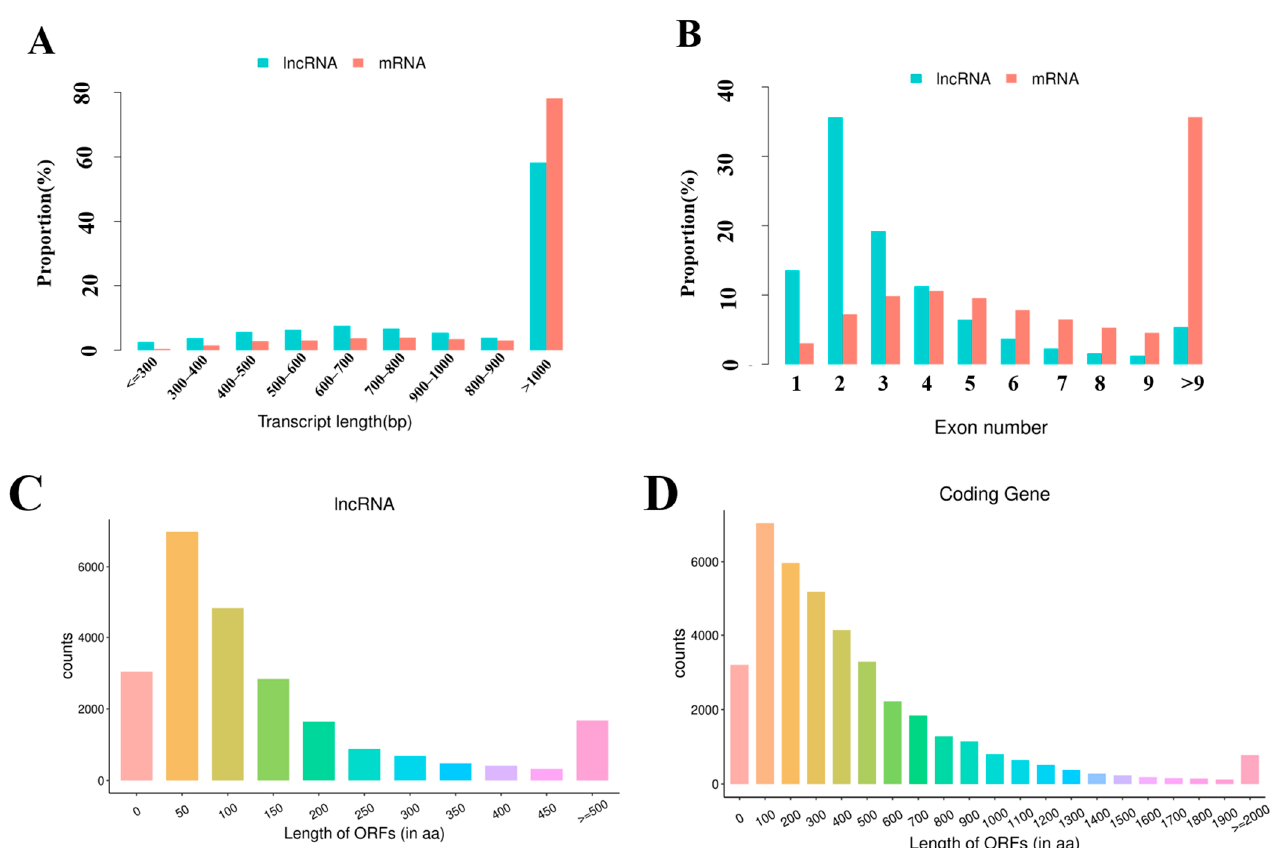
Figure 2. Genomic features of lncRNAs in mouse spleens. ( A ) The transcript length distribution of lncRNAs and mRNAs. ( B ) The exon number distribution of lncRNAs and mRNAs. ( C ) The ORFs length distribution of lncRNAs. ( D ) The ORFs length distribution of mRNAs.